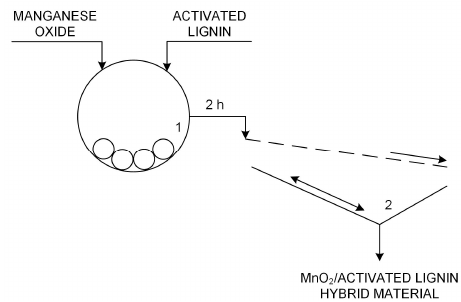
Figure 19. Technological scheme of preparation of manganese dioxide/activated lignin hybrid materials—simplified technological process (1—grinder mortar, 2—automatic sieve).